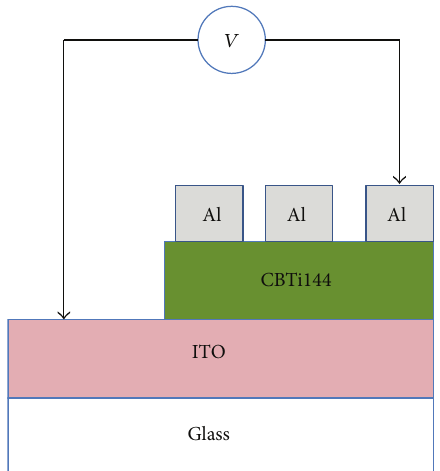
Figure 1: Metal-insulator-metal (MIM) capacitor structure of the CBTi144 RRAM device.